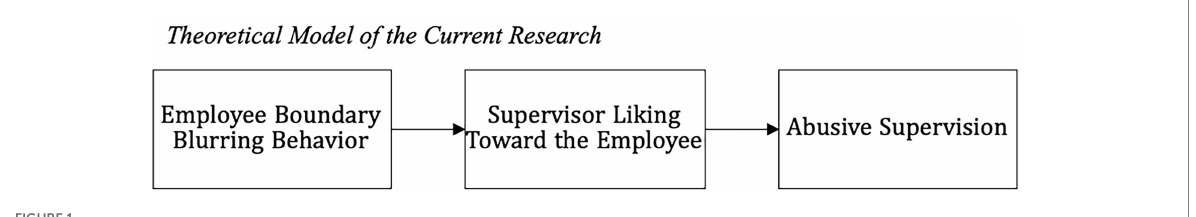
FIGURE 1 Theoretical model of the current